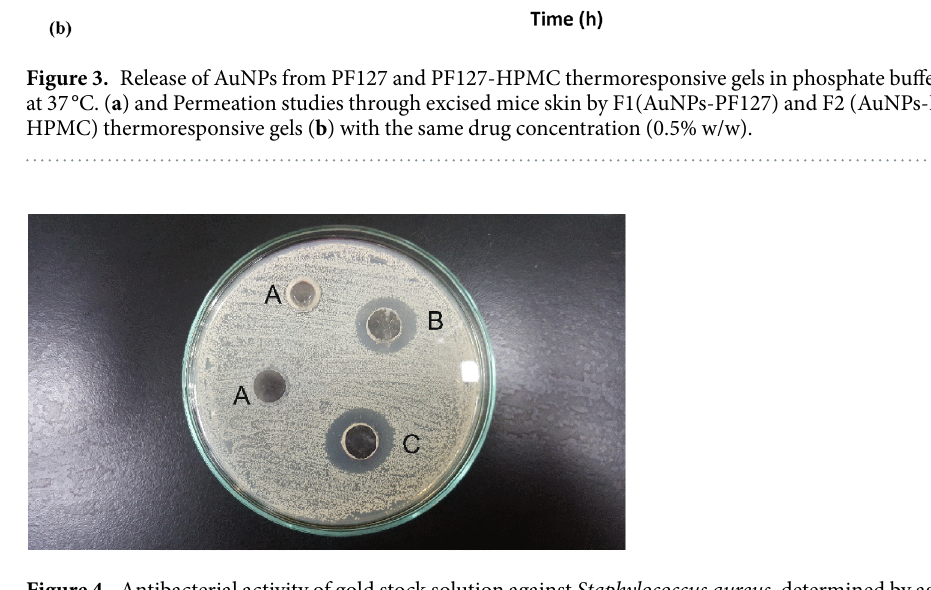
Figure 4. Antibacterial activity of gold stock solution against Staphylococcus aureus , determined by agar well diffusion method. A: 0.25 µ g Au ( a ), B: 0.5 µ g Au ( b ) and C: 2.5 µ g Au ( c